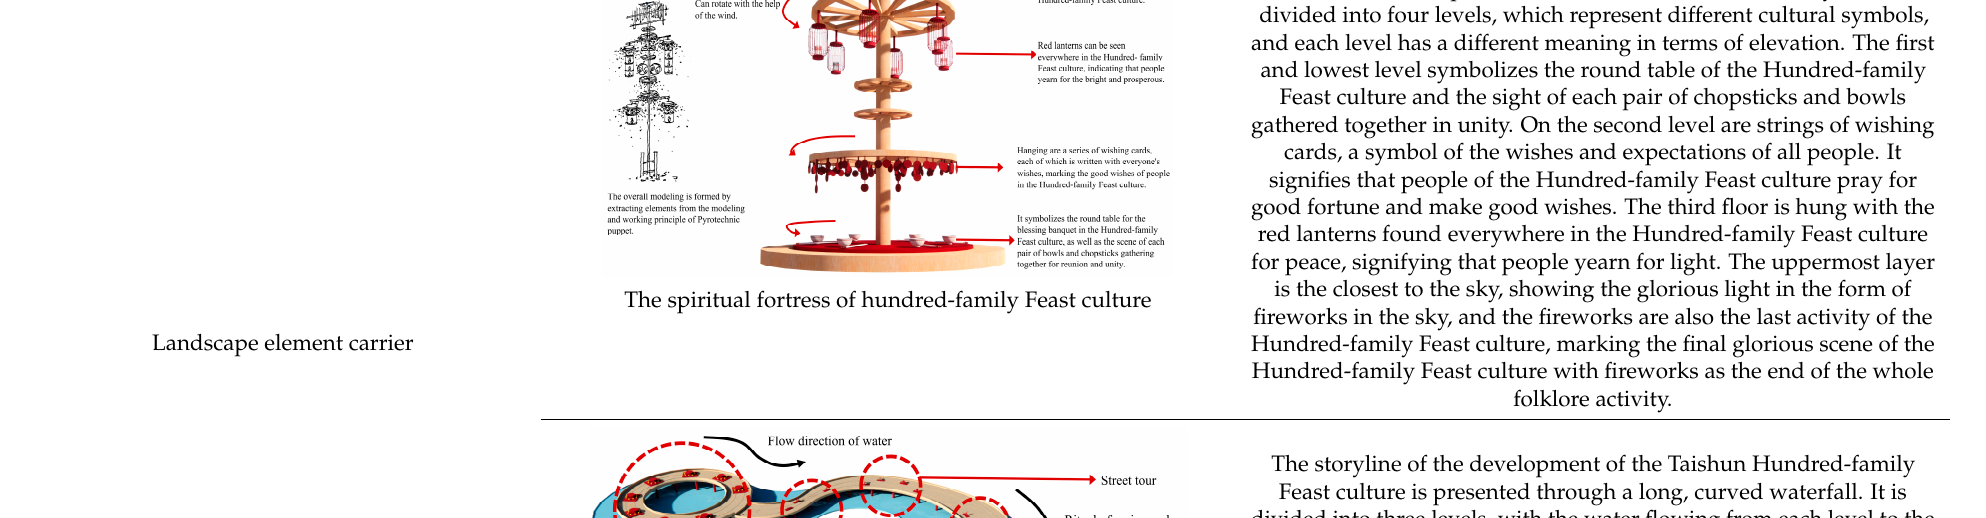
Table 3. The landscape element carrier and spatial carrier in the Hundred-family Feast cultural entrance experience zone. Figure Explanation